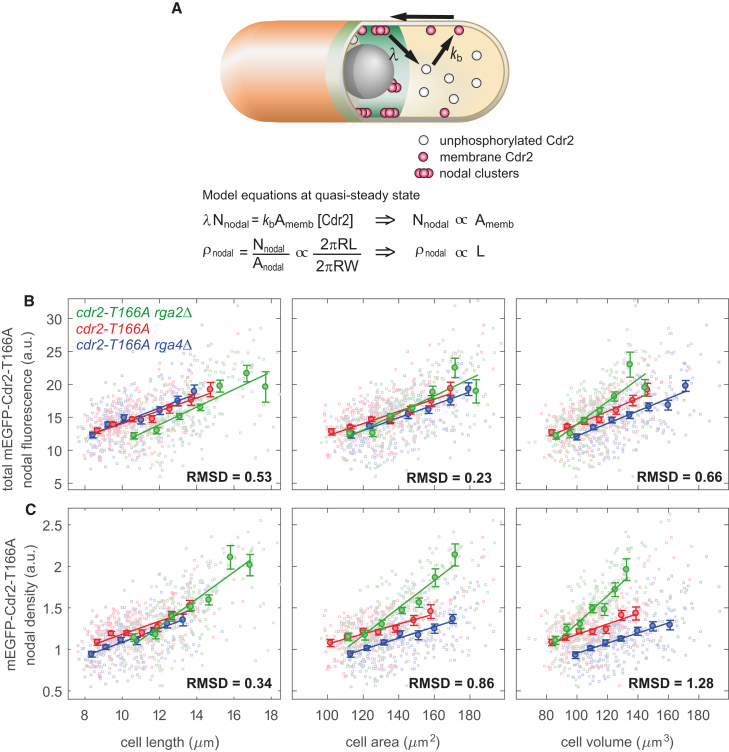
Model Prediction and Validation of Altered Geometrical Scaling for Nodal Cdr2-T166A Levels(A) Schematic of the model for cdr2-T166A mutant (STAR Methods). Equations predict length scaling of Cdr2-T166A nodal density. Symbols are as in Figure 2C, with the addition of kb as binding constant of unphosphorylated Cdr2 to cell membrane.(B) Plots of total nodal fluorescence of Cdr2-T166A for cdr2-T166A rga2Δ, cdr2-T166A, and cdr2-T166A rga4Δ as function of length, surface area, and volume.(C) Plots of nodal density of Cdr2-T166A, otherwise as in (B).Color legend: cdr2-T166A rga2Δ (FC3180; green; n = 150), cdr2-T166A (FC3164; red; n = 151), and cdr2-T166A rga4Δ (FC3183; blue; n = 140). Binned data (with mean value ± SE) and associated regression line are shown in (B) and (C). Normalized RMSD (between binned data; STAR Methods) is also stated in (B) and (C); t tests on normalized RMSDs all give p values < 10−5.See also Figure S3.